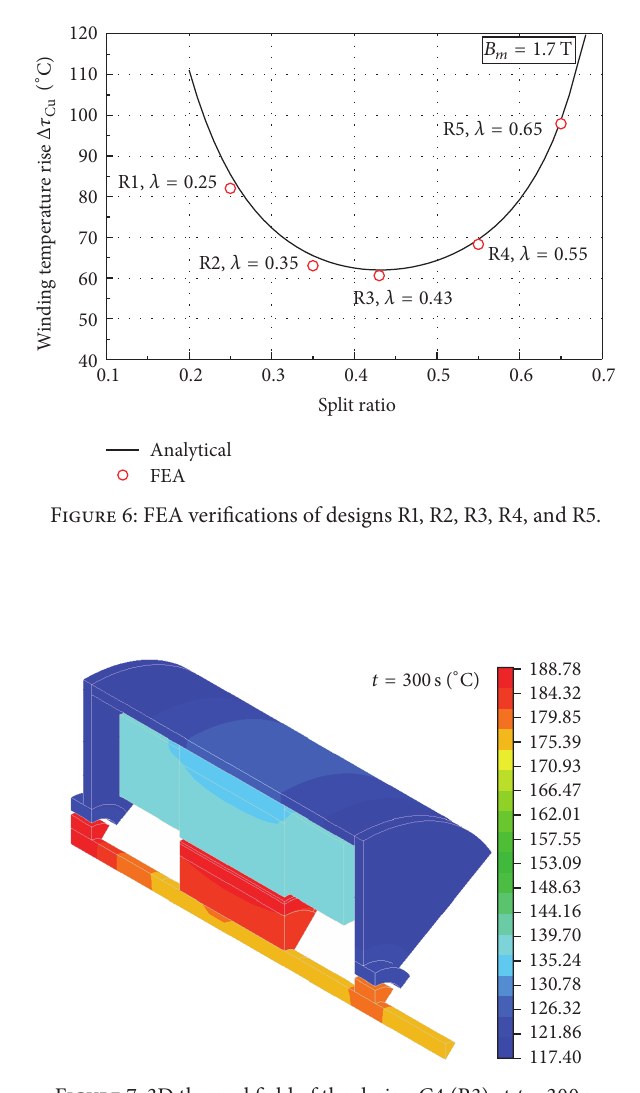
Figure 7: 3D thermal field of the design C4 (R3) at t = 300